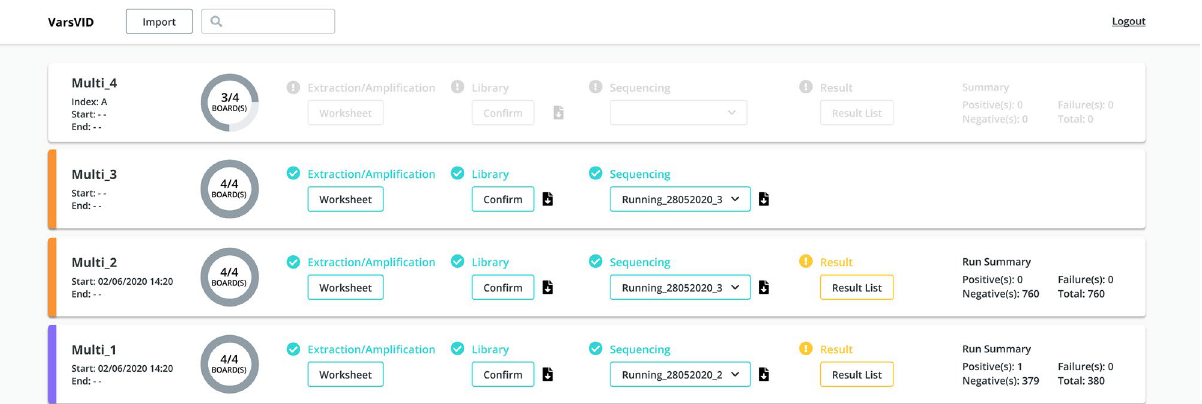
Figure 4. Front-end of the VarsVID online platform, where users can register samples, check wet-lab steps completion, and inspect results. Print screen obtained directly from the